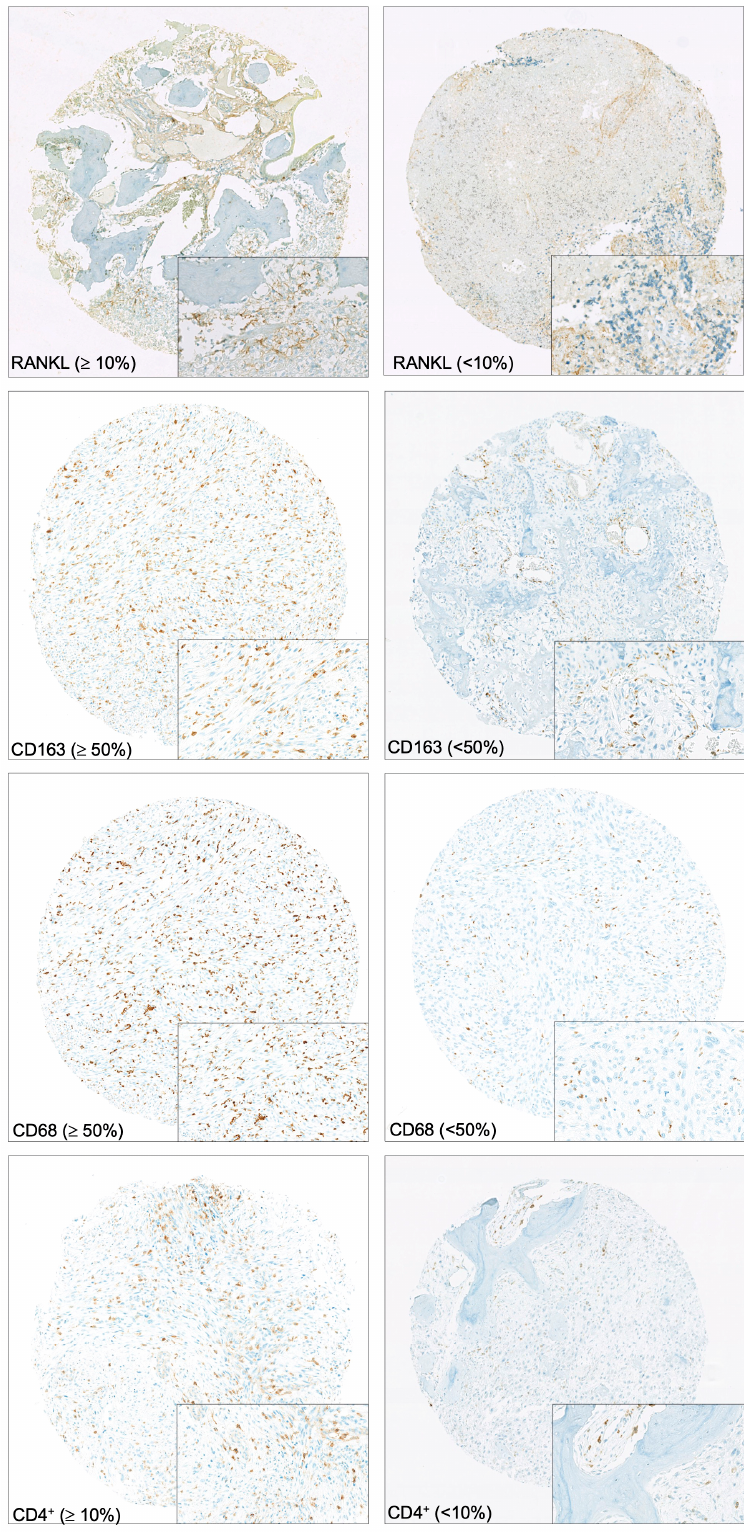
Figure 1. Immunohistochemical staining. Sample images of tissue microarrays prepared from patient biopsies and stained for RANKL, CD163, CD68, and CD4 + (magnification × 7). Frames correspond to a high-power field of each image (magnification ×40).